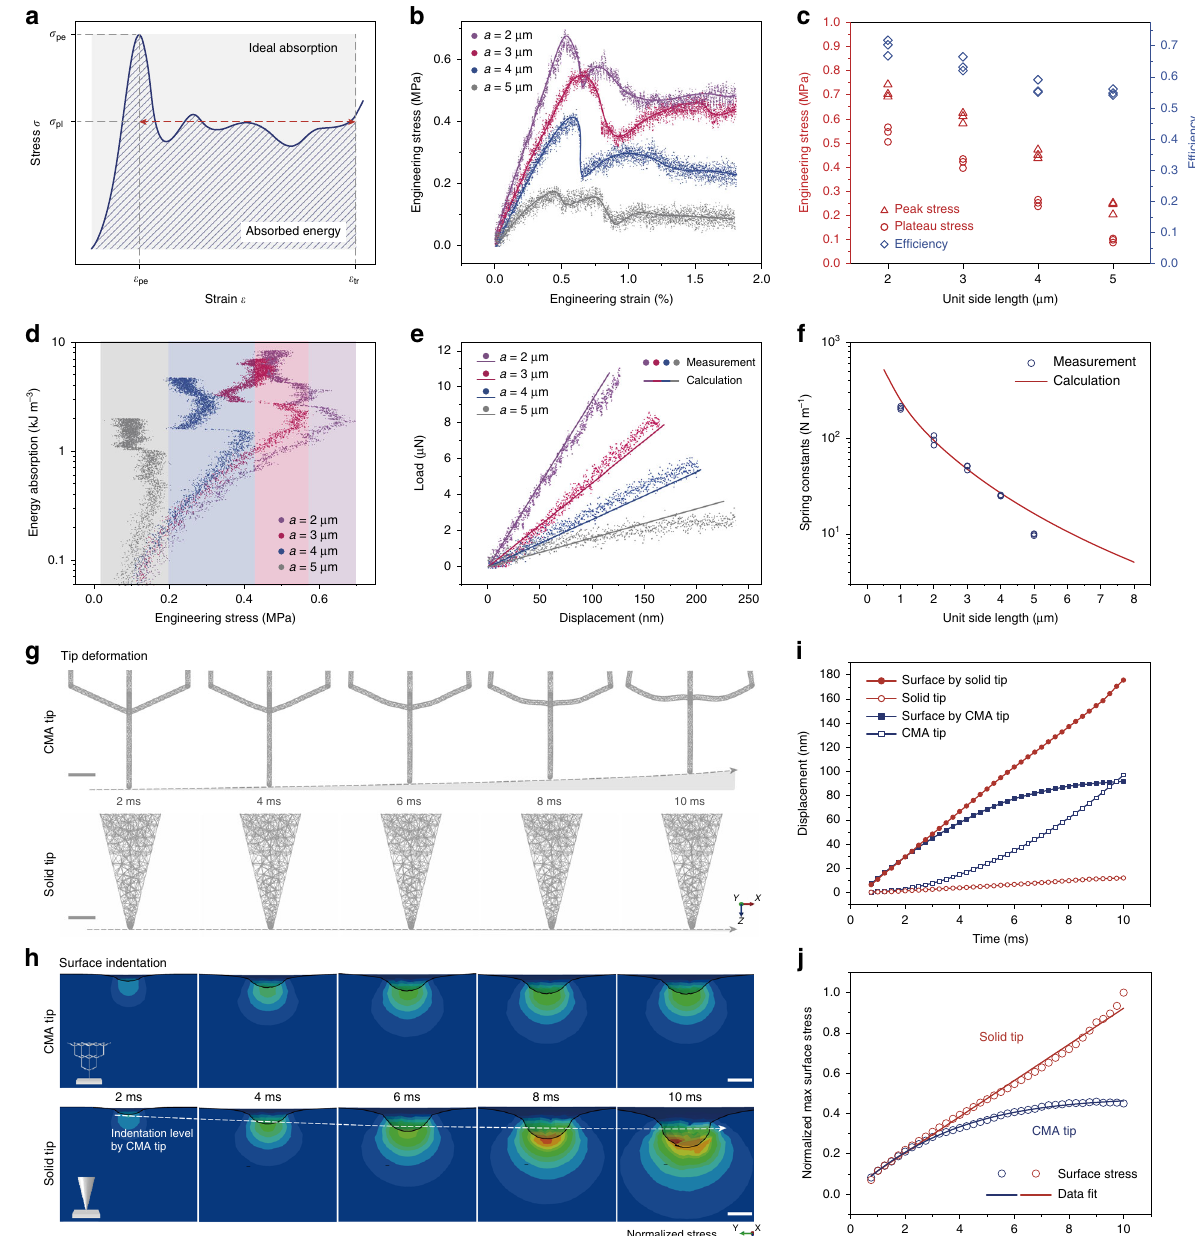
Fig. 2 Mechanical characterization of CMA structures. a – d Characterization of the energy-absorbing performance of CMA structures by instrumented indentation tests (IIT). a Schematic of typical stress – strain ( σ (cid:1) ε ) curve of materials in response to compression, with its key features of peak stress σ plateau stress σ pl , peak force strain ε pe and strain threshold ε tr marked in the plot. b Engineering stress – strain features of CMA structures with different unit side lengths obtained from IIT at a strain rate of 10 − 1 s − 1 . c Calculated engineering stress (plateau stress and peak stress) and energy-absorbing ef fi ciency of CMA structures (represented by unit side length). d Energy absorption diagram showing the amount of absorbed energy per unit volume as a function of str e sses at the given strains. e , f FEA simulation of the elastic compressive response of CMA structures based on static loading. e Load-displacement features of CMA structures in the linear elastic regime. The solid lines are simulation predictions. f Calculated and measured spring constants versus structures with different unit side lengths. g – j Dynamic tip – sample impact simulation based on dynamic fi nite element analysis (FEA). The tips have an initial speed of 20 μ m s -1 in + z direction approaching and impacting the sample surface (see Supplementary Movie 1). g Morphological evolutions of a CMA tip ( a = 5 μ m) and a solid cone tip during the fi rst 10 ms of the impact. All tips are displayed in a render style of wireframes. h Time-lapse indentation cross-sections and normalized local stress distributions on the sample within the fi rst 10 ms (tips are concealed) by employing the CMA tip and the solid tip as shown in the insets. For comparison, the dashed arrow line indicates the evolution of the indentat i on level by the CMA tip. i Tip displacement and max interfacial indentation depth over time. j Normalized maximum interfacial stress versus time. Scale bars are 1 μ m for g and 100 nm f or h . Source data of b – f , i , j are provided as a Source Data fi